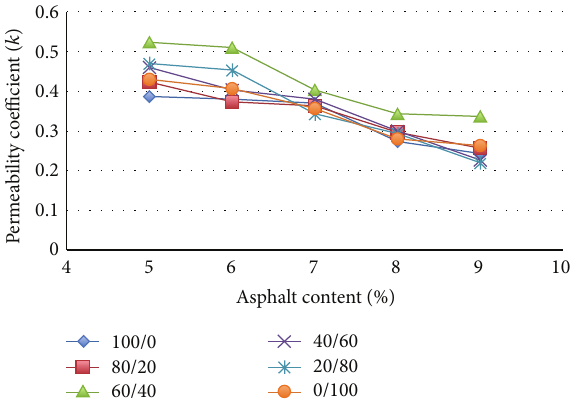
Figure 3: Permeability coefficient ( 𝑘 ) at each asphalt content and coarse aggregate proportion.